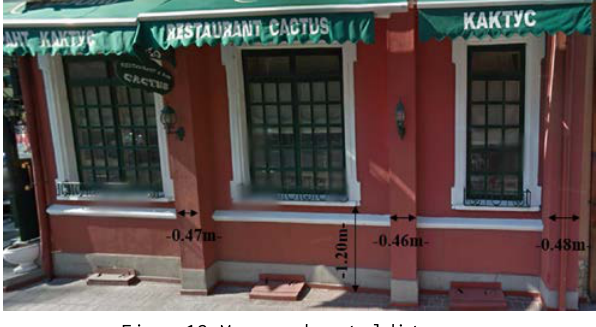
Creation of a 3D model is made by AutoDesk Civil 3D. The results are shown at figures 13, 14, 15 and